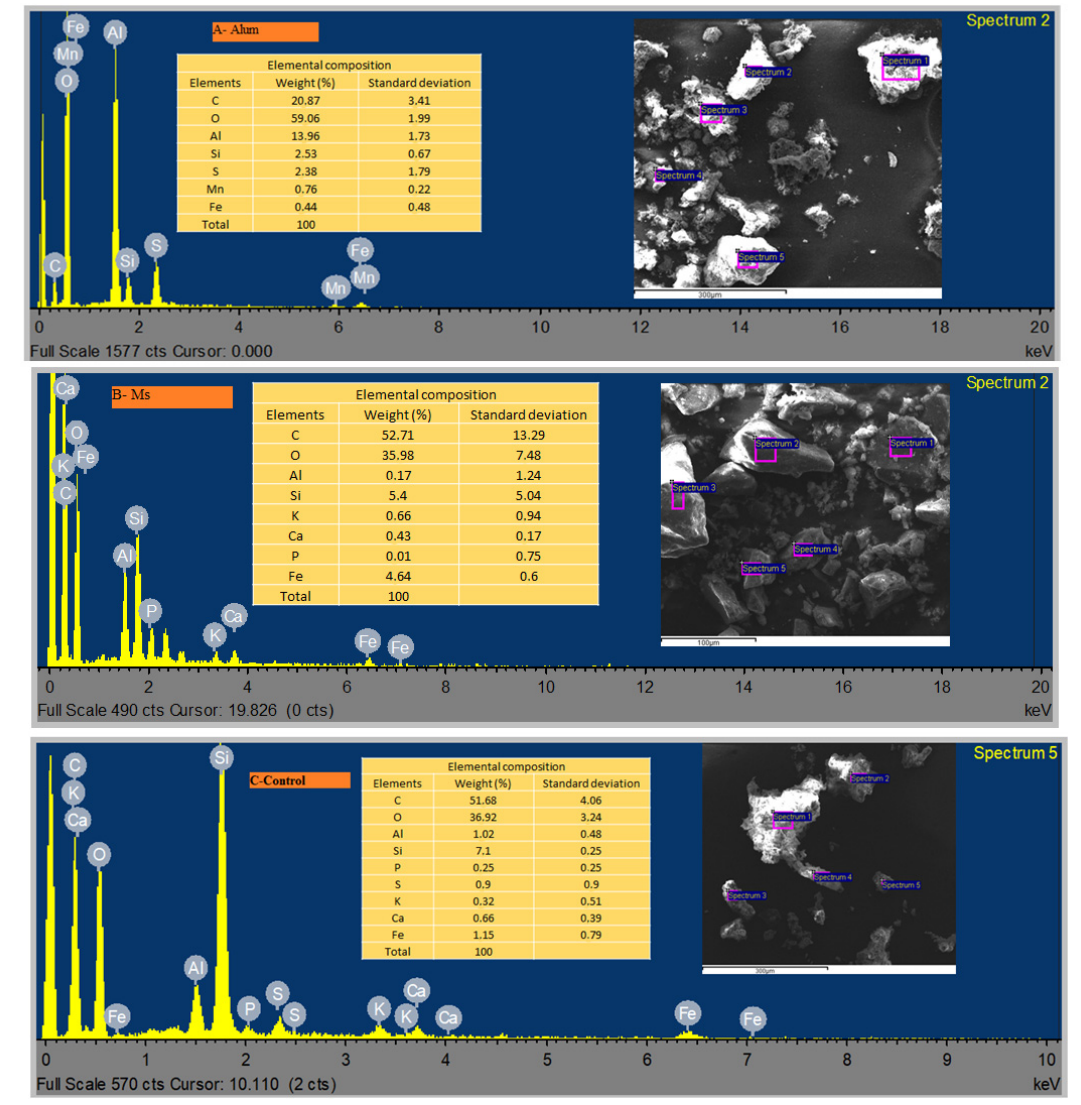
Figure 9. Energy dispersive X-ray spectrometer (EDS) image showing tracing nanoparticles (NPs) in digester sludge of set-up A—Alum ( A ) increasing order C > O > Al > Si > S > Mn > Fe; set-up B—Ms ( B ) increasing order C > O > > Si > Fe > K > Ca > Al > P and set-up C—Control ( C ) increasing